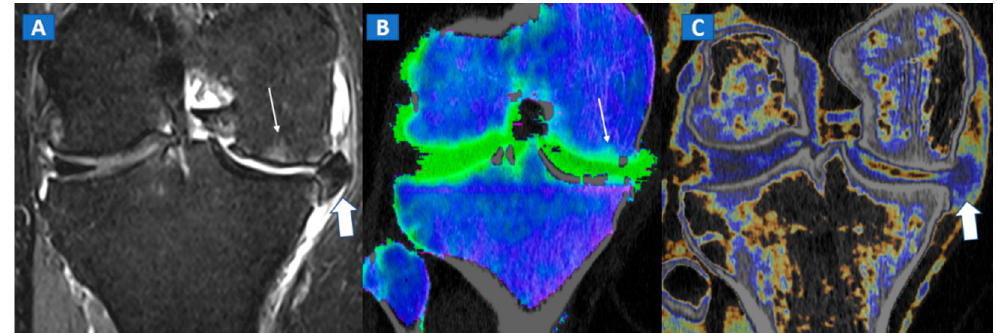
Figure 4. A 65-year-old female with non-traumatic medial-sided knee pain. On the coronal STIR MRI image ( A ) the body of the medial meniscus is ruptured and medially dislocated (thick arrow). Tiny, subtle BME areas can be seen on the femoral condyle (thin arrow) due to advanced chondropathy. Tiny areas of BME (thin arrow) are also depicted on the corresponding coronal 1 mm reconstructed DECT image ( B ). By using alternative color-coding ( C ), DECT allows the depiction of the ruptured meniscus (thick arrow), providing a good correlation with MRI findings.